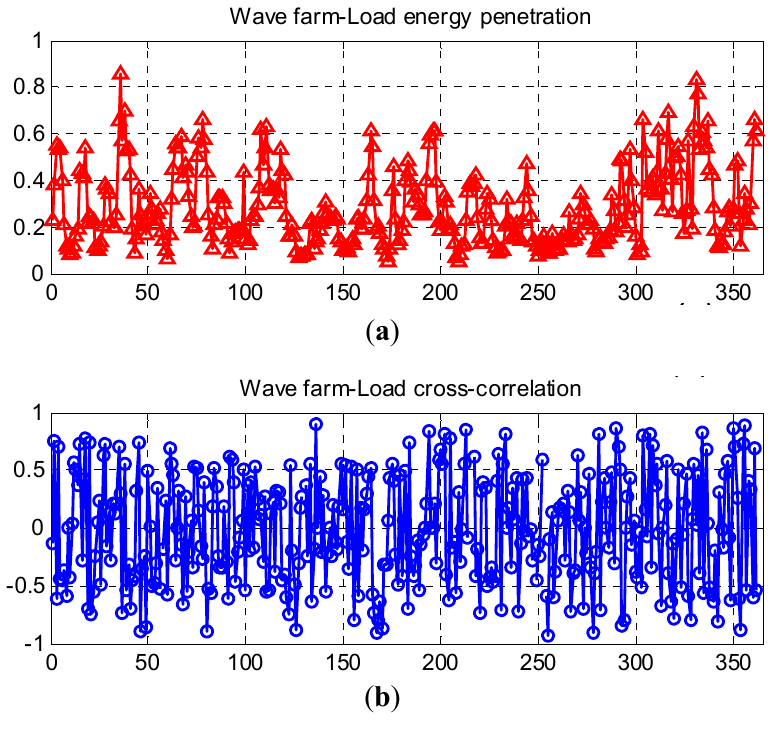
Figure 7. ( a ) Daily wave energy penetration for considered Case 2; ( b ) Daily cross-correlation for both considered Case 2 and Case